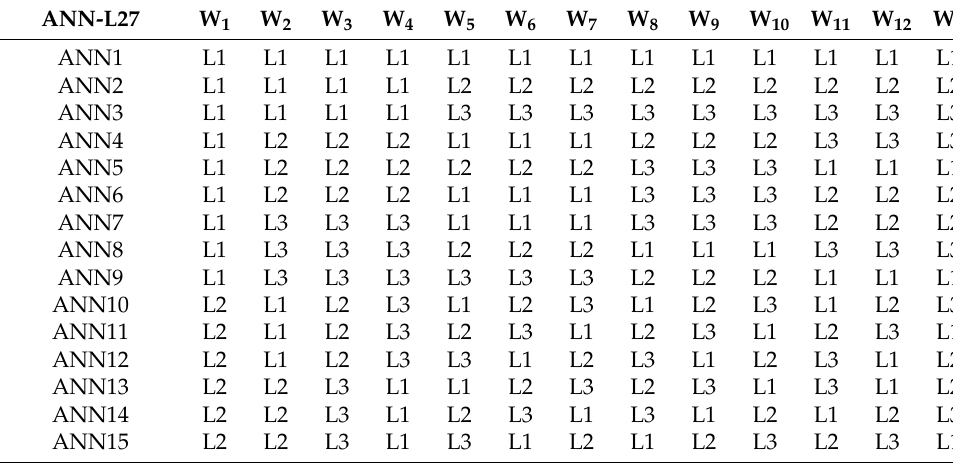
Table 2. ANN-L12 orthogonal vector plan.